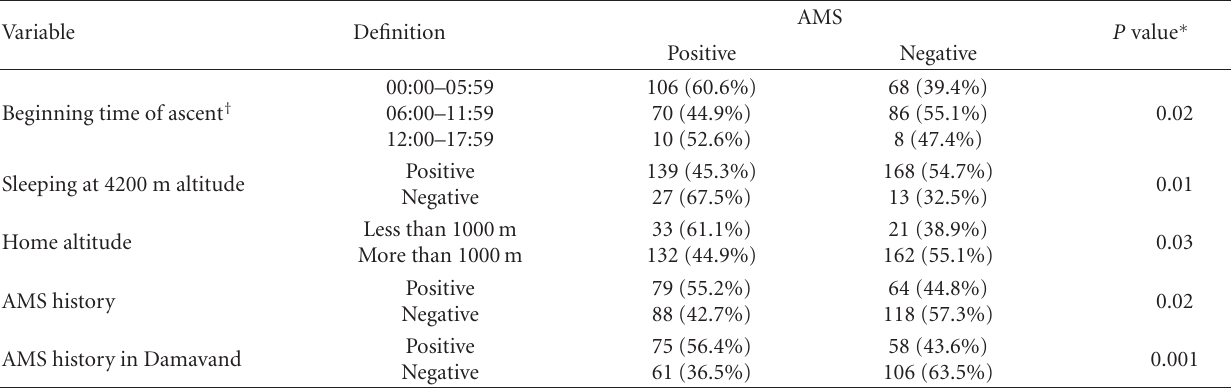
Table 4: Variables associated with incidence of disease in the univariate analysis.